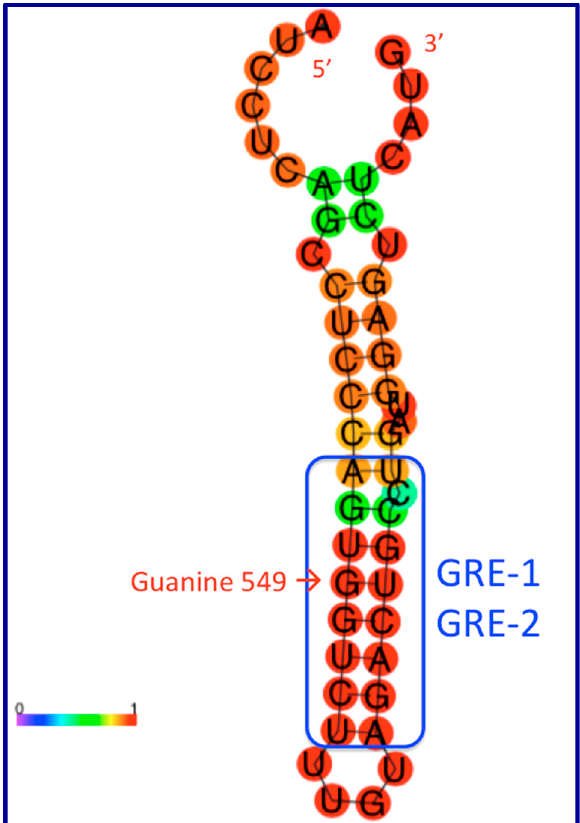
Figure 2. One well-supported molecular mechanism through which the human GAS5 lncRNA acquires a phenotype involves the folding of a small (49 nt) region common to multiple RNA isoforms into a stem-loop structure with high stability--where the stems create an RNA mimic (GRE, blue box) capable of competitive binding of the glucocorticoid receptor (a known DNA-binding protein). The colored RNA structure is drawn using the web-based server found at: http://rna.tbi.univie.ac.at/cgi-bin/RNAWebSuite/RNAfold.cgi The key guanine residue (G549) described by Hudson et al . [74] is indicated with a red arrow inside the blue box.